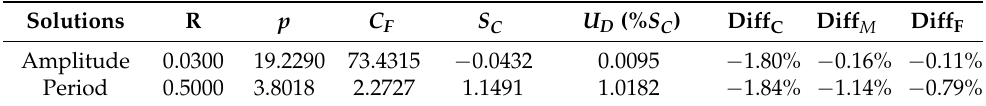
Table 7. Grid uncertainties of free heave motion.